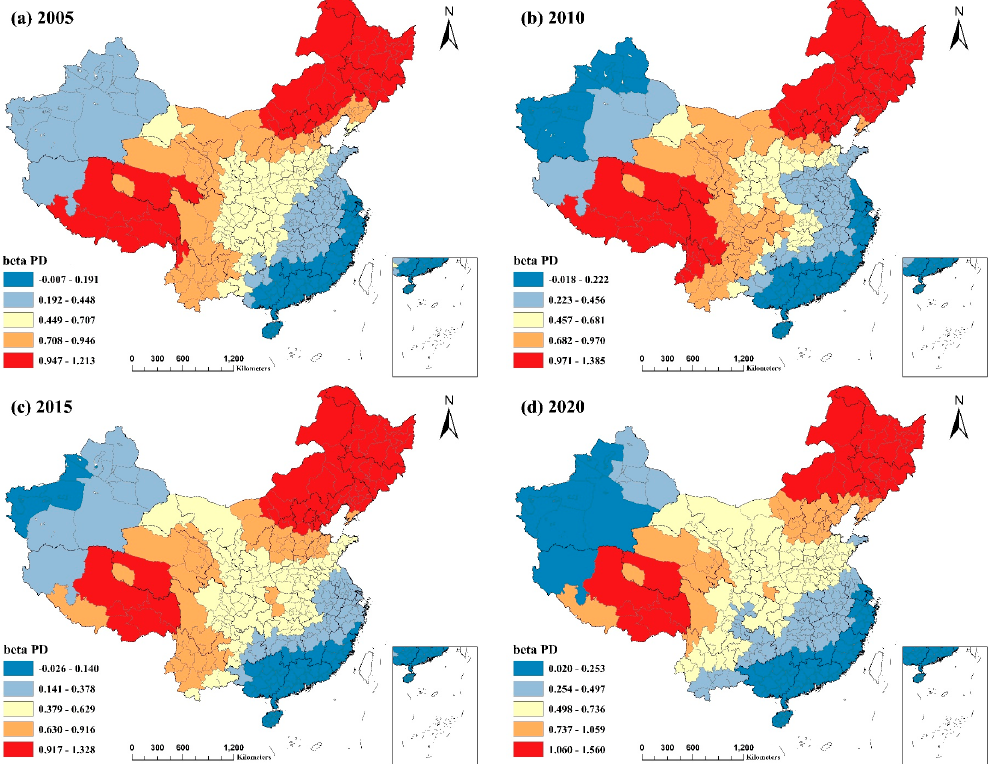
Figure 10. Spatial and temporal distribution of regression coefficients of population density in the MGWR model, 2005 − 2020: ( a ) spatial and temporal distribution of regression coefficients for population density in 2005; ( b ) spatial and temporal distribution of regression coefficients for population density in 2010; ( c ) spatial and temporal distribution of regression coefficients for population density in 2015; ( d ) spatial and temporal distribution of regression coefficients for population density in 2020.